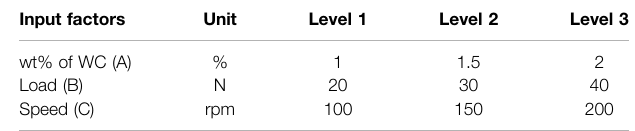
TABLE 1 | Control factors and